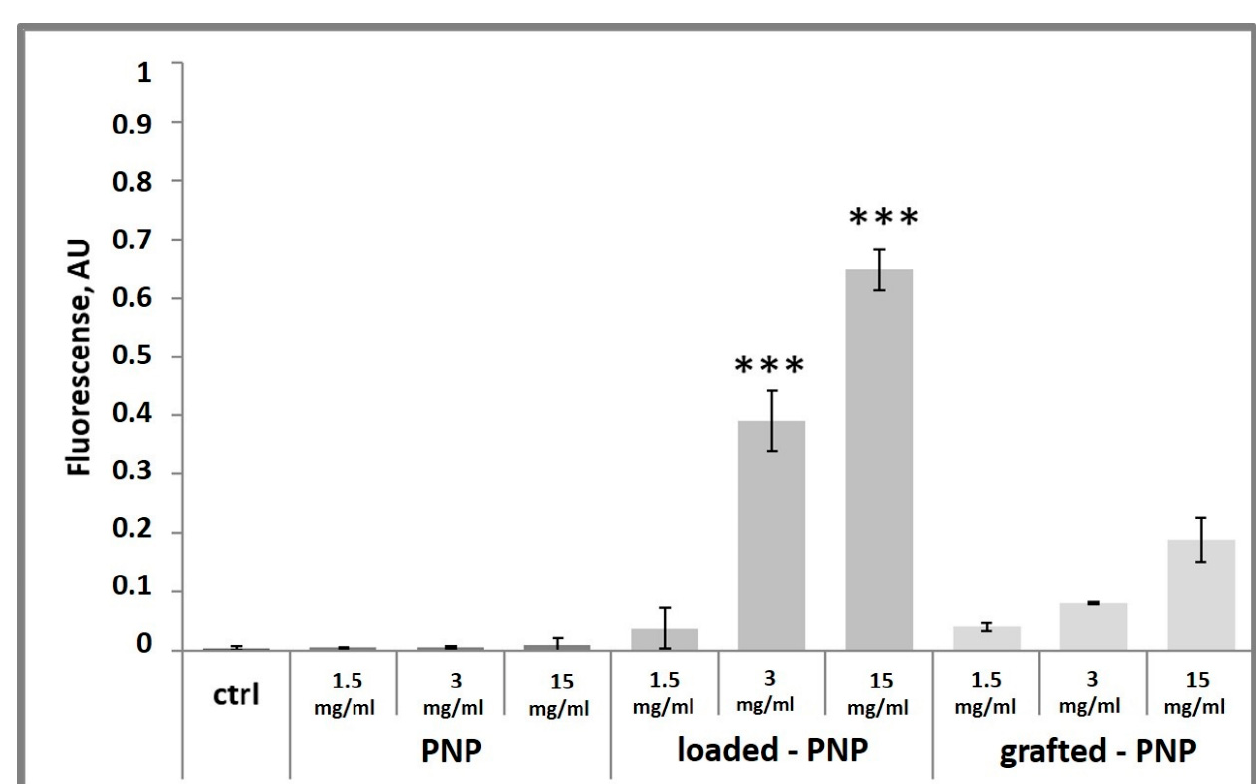
Figure 12. Detection of intracellular RhdB emission in d-PC12 cells. Cells were treated 24 h with NPs or RhB (data not shown) and then analyzed by a Varioscan multimode microplate reader. Results are represented as the increase in fluorescence, normalized with live-cell fluorescent staining of DNA Hoechst33342, with respect to untreated control cells. Results are presented as mean ± SD. (*** p < 0.001 versus grafted-PNP, one-way ANOVA).